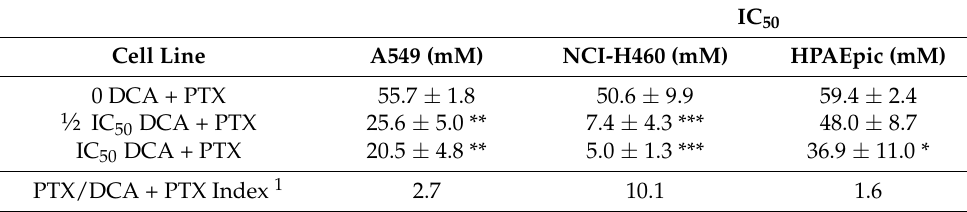
Table 2. The effect of DCA pre-incubation in the IC 50 values of PTX in A549, NCI-H460 and HPAEpic cell lines. The results are presented as means ± SD of at least three independent experiments. * p <